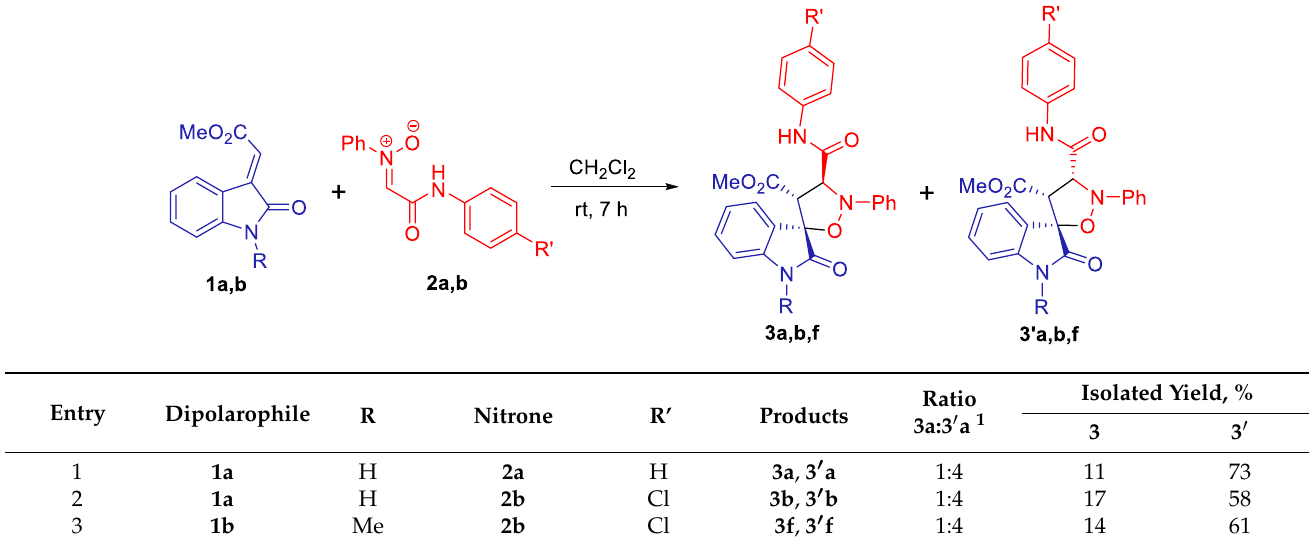
Table 3. Cycloaddition of 2-(2-oxoindoline-3-ylidene)acetates 1a,b with C -carbamoyl nitrones 2a,b at rt.